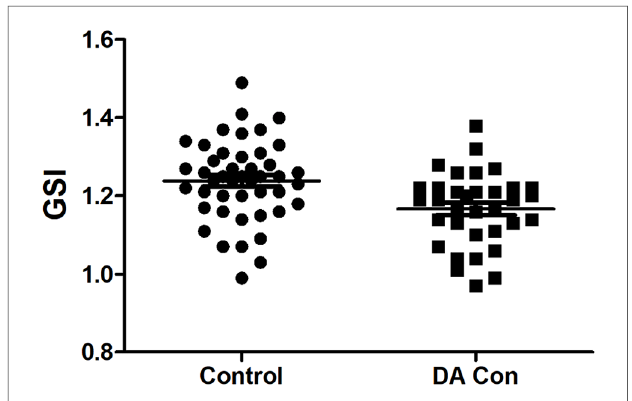
FIGURE 2 Scatter plot of global sphericity index (GSI) in the fetuses with ductus arteriosus premature contraction (DA Con) and control group ( P